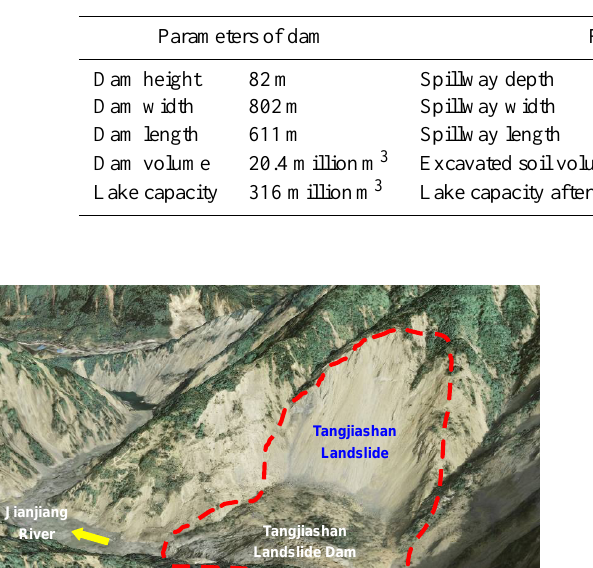
Table 1. Parameters of Tangjiashan landslide dam.